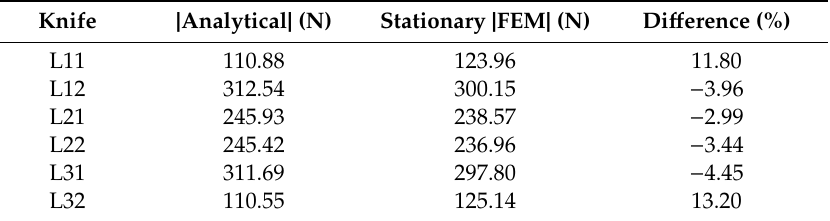
Table 6. Comparison of electrodynamical forces for stationary